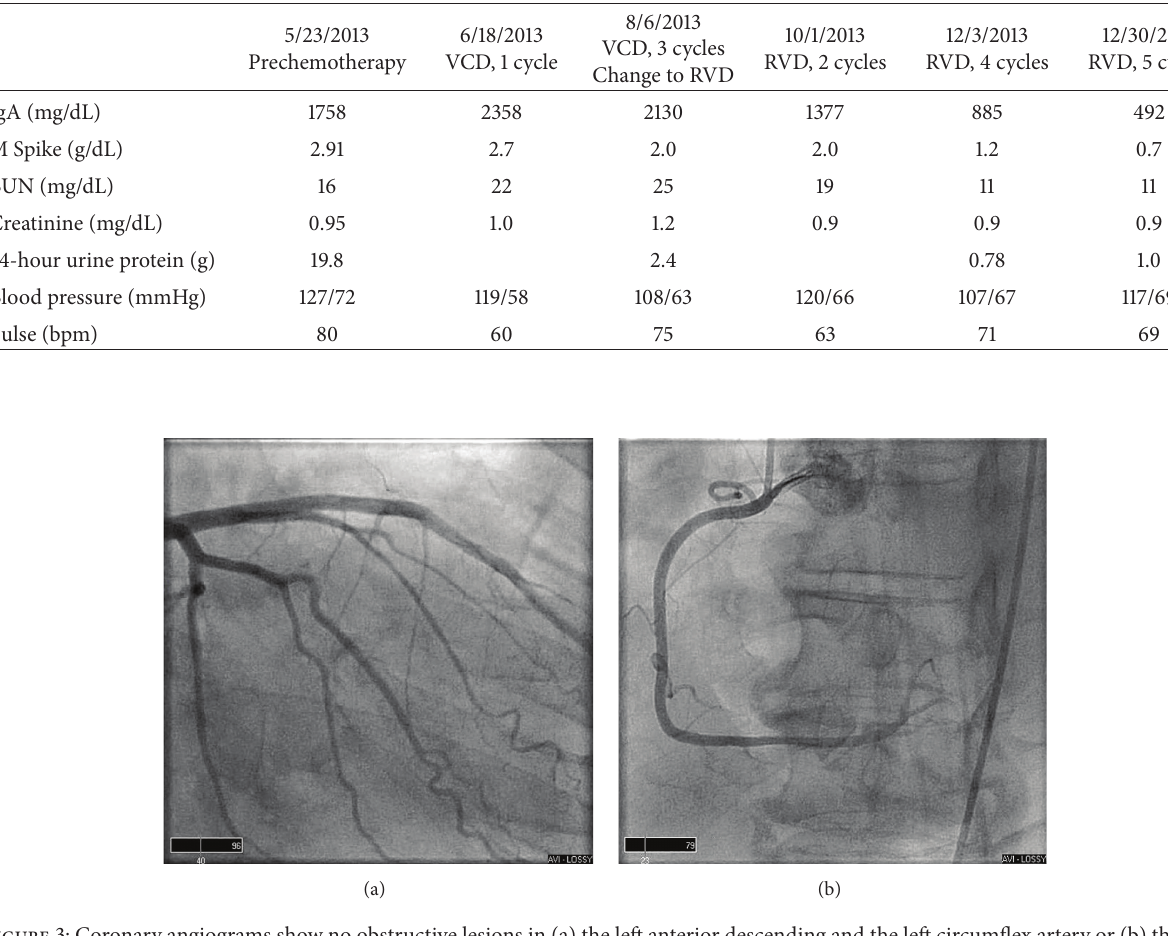
Table 1: Multiple myeloma treatment summary with relevant clinical and laboratory parameters.